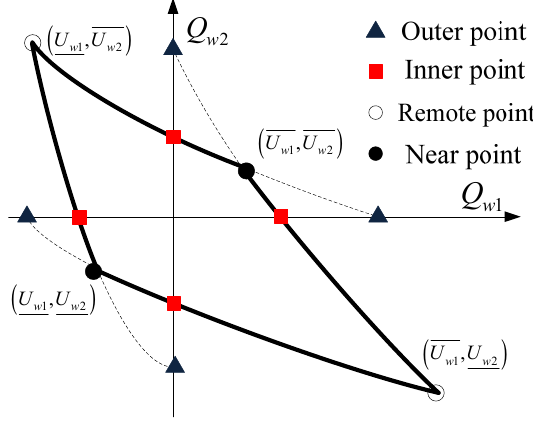
Figure 5. Definition of inner, outer, near, and remote